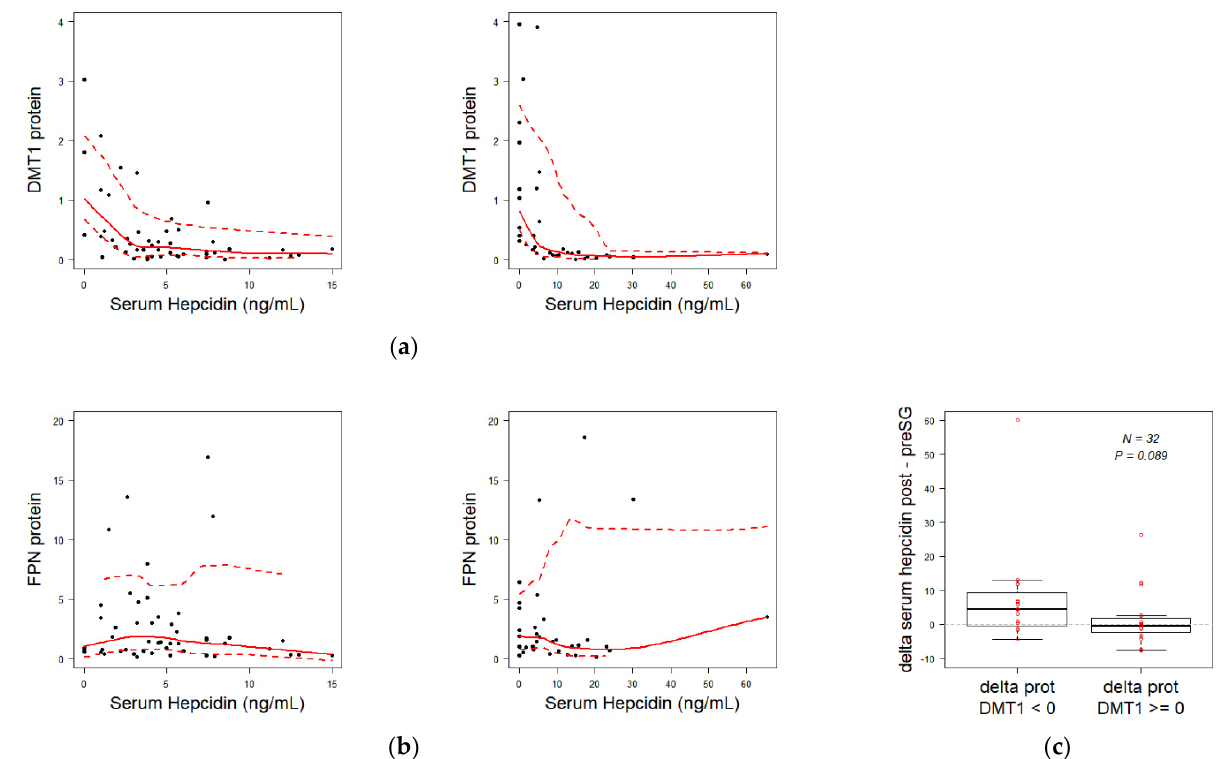
Figure 4. Correlation between serum hepcidin and duodenum protein iron transporters. ( a ) correlation between pre-surgery (left panel) and post-surgery (right panel) serum hepcidin concentration and DMT1 protein (R = − 0.045; p = 0.001 and R = − 0.385; p = 0.022, respectively). ( b ) correlation similar to ( a ) for FPN protein (R = − 0.117; p -value = 0.466 and R = 0.126; p = 0.47, respectively). ( c ) comparison of differences in serum hepcidin concentrations after and before surgery between two subgroups of patients: patients whose DMT1 protein decreased after surgery versus patients whose DMT1 protein did not decrease.